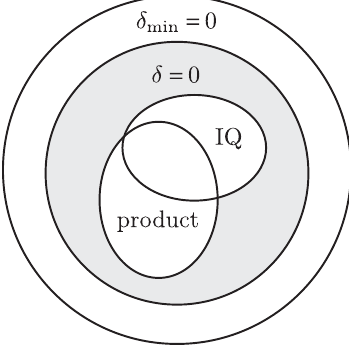
FIG. 5. Schematic illustration of the sets for which the B j A Þ (CQ states), δ ð B j A Þ following quantities vanish: δ min ð (Result 2), C ð B j A Þ (IQ states), and I ð A ∶ B Þ (product states). When A is a qubit, the shaded region is